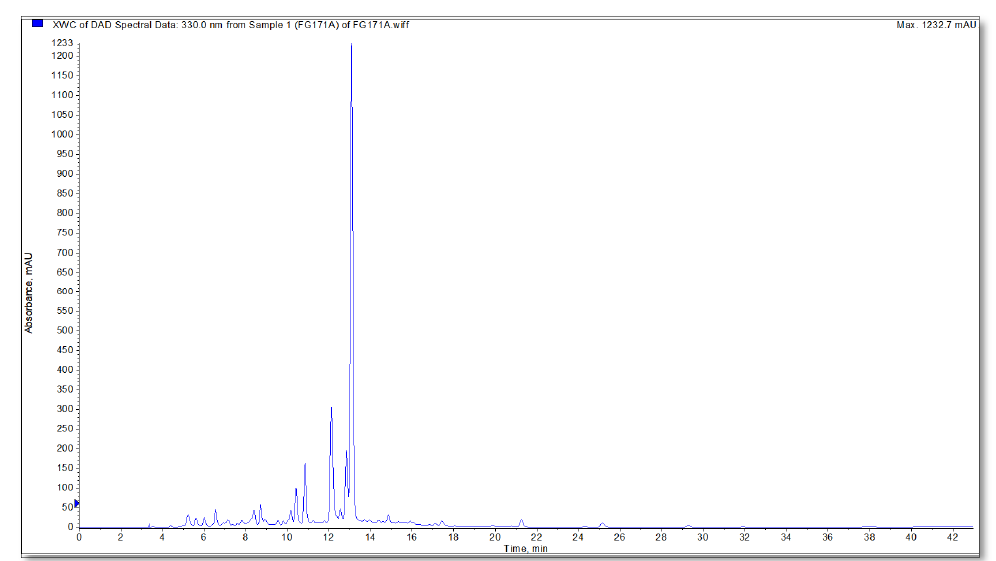
/ MS / MS chromatogram of 70% MeOH extract of S. aramiensis Figure 2. LC/MS/MS chromatogram of 70% MeOH extract of S. aramiensis . Figure 2. LC